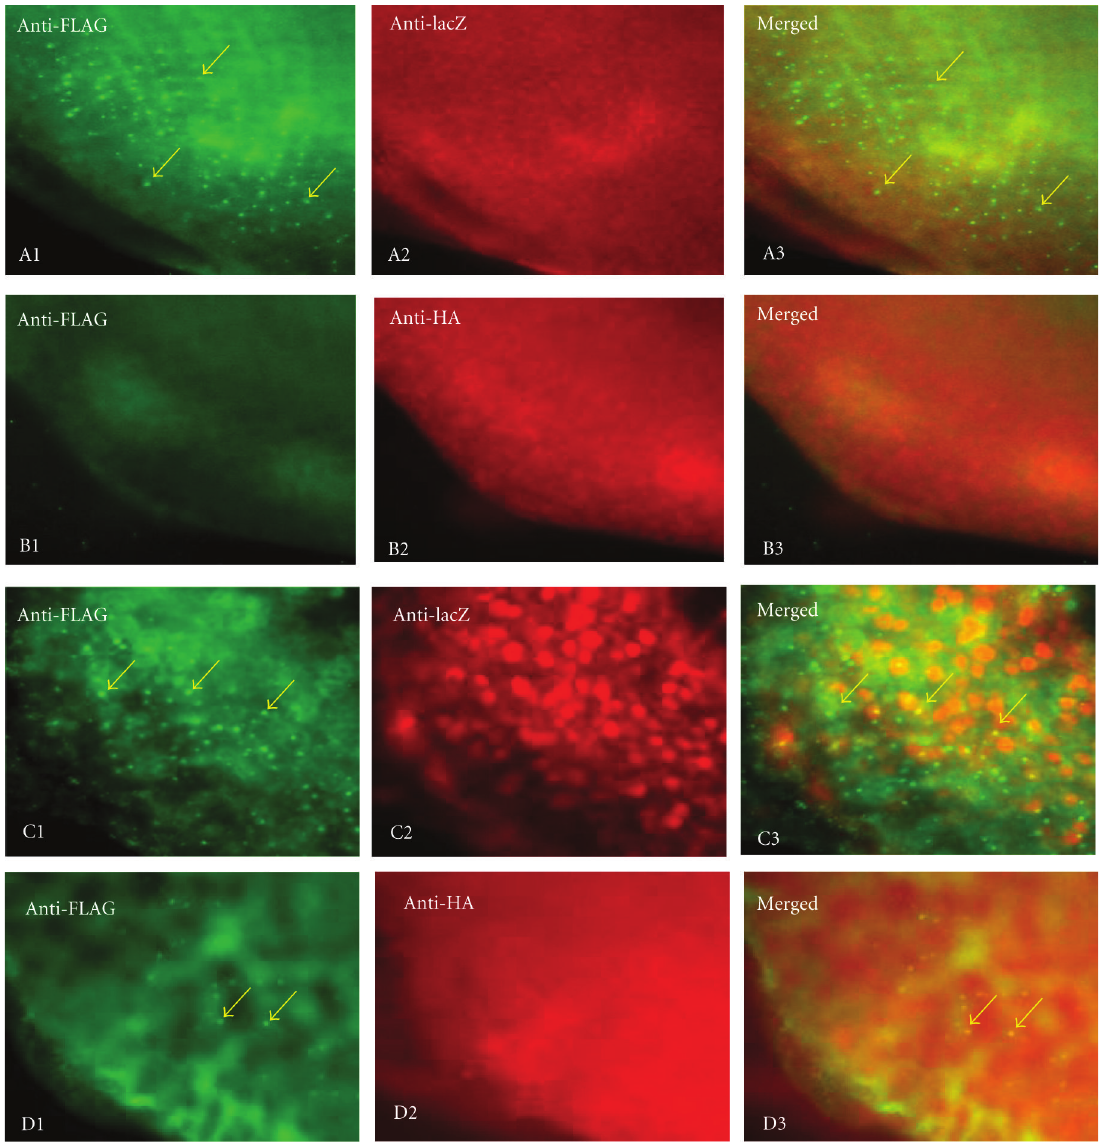
Figure 3: Suppression of Q92 aggregate formation by expression of α B-crystallin in the imaginal discs of the Q92 flies. The eye discs were immunostained with anti-FLAG antibody to detect Q92 tagged with FLAG (green) and anti-HA or anti-LacZ antibodies to detect α B- crystallin-HA (red) and lacZ, respectively (red). The arrows indicate examples of Q92 aggregates. (A1–A3) gmr-gal4; gmr-Q92/+; uas- lacZ . (B1–B3) gmr-gal4; gmr-Q92/+; uas- α B-crystallin-HA . (C1–C3) gmr-gal4; 2x ( gmr-Q92 ) /+; uas-lacZ . (D1–D3) gmr-gal4; 2x ( gmr-Q92- FLAG ) /+; uas- α